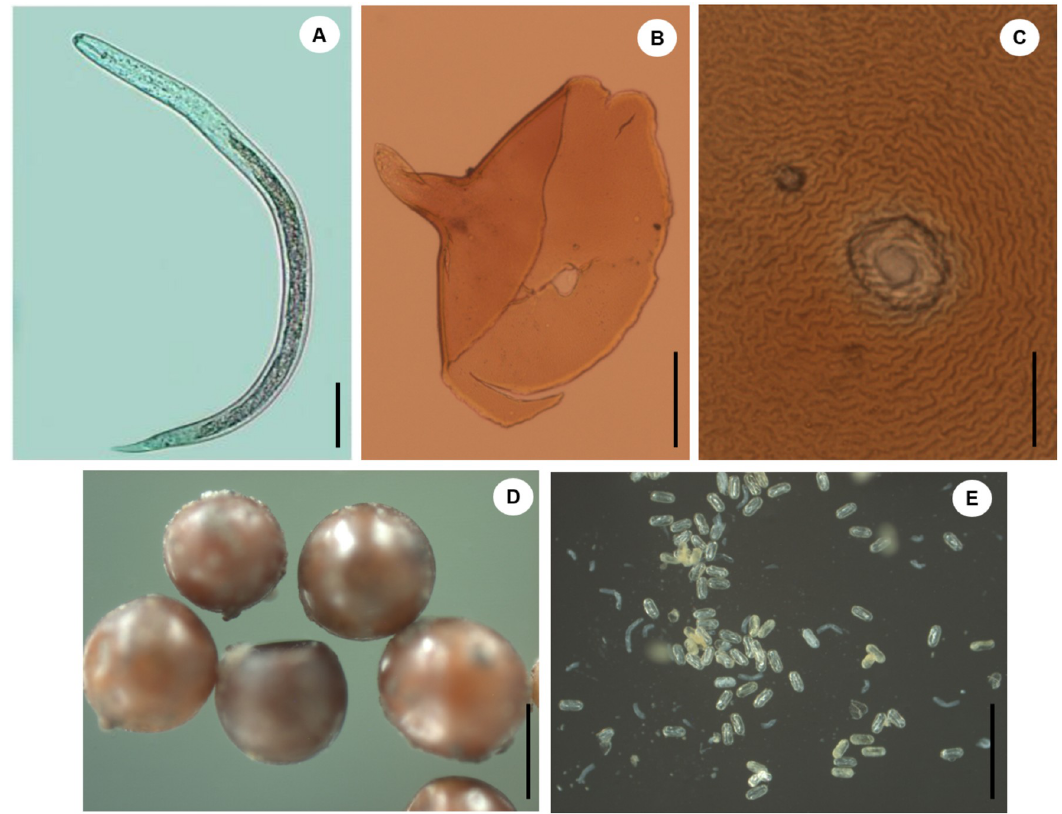
Fig 2. Light micrographs of Globodera pallida from Colombia (Population B2: Ventaquemada, Boyaca´). A) Second-stage juvenile. B) Anterior region. C) Cysts. D) Eggs. Scale bars: A-C = 50 μ m; D, E = 100 μ m.